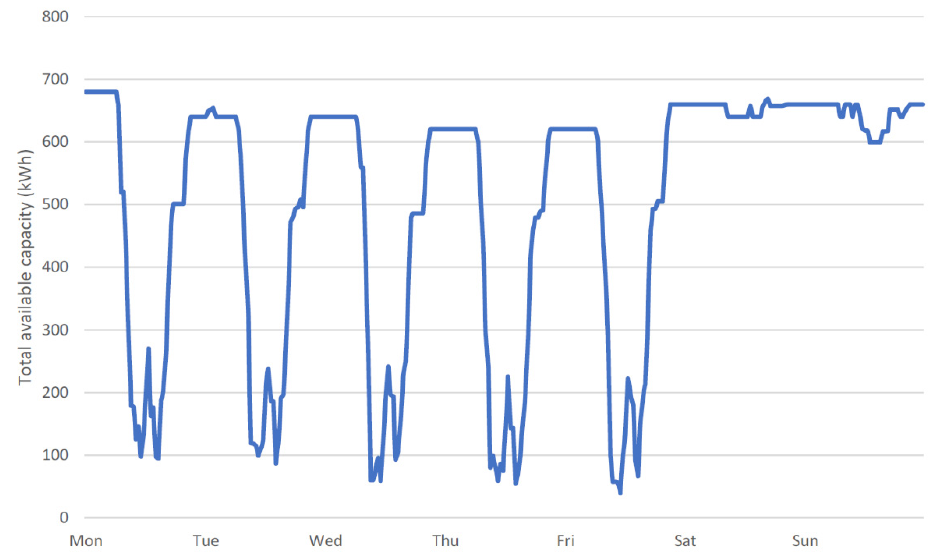
Figure 4. Typical weekly profile for total available capacity from the fleet of vehicles.